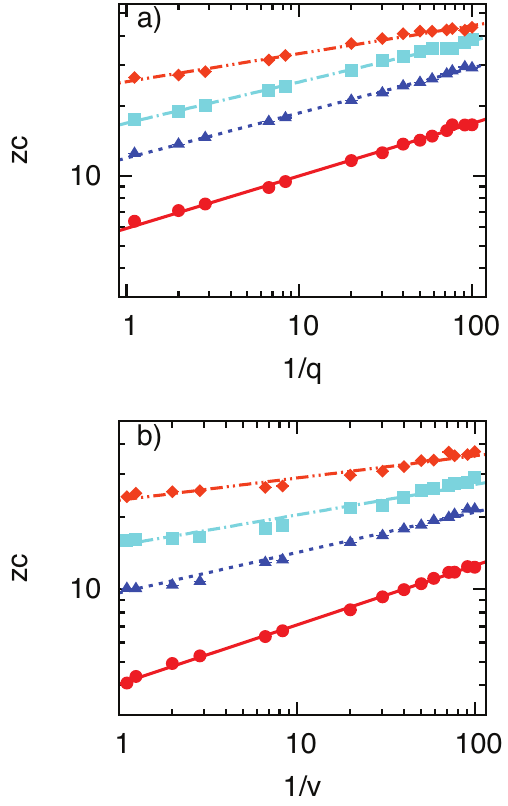
Figure 5. Relationship between z c and t q in a) and t v in b). Points mark the simulation results and lines correspond to fitted functions: a): z c ( t q ) ~ a q t b and b): z c ( t v ) ~ a v t b ’ for red: z inf ~ 1 , navy blue: z inf ~ 3, q v blue: